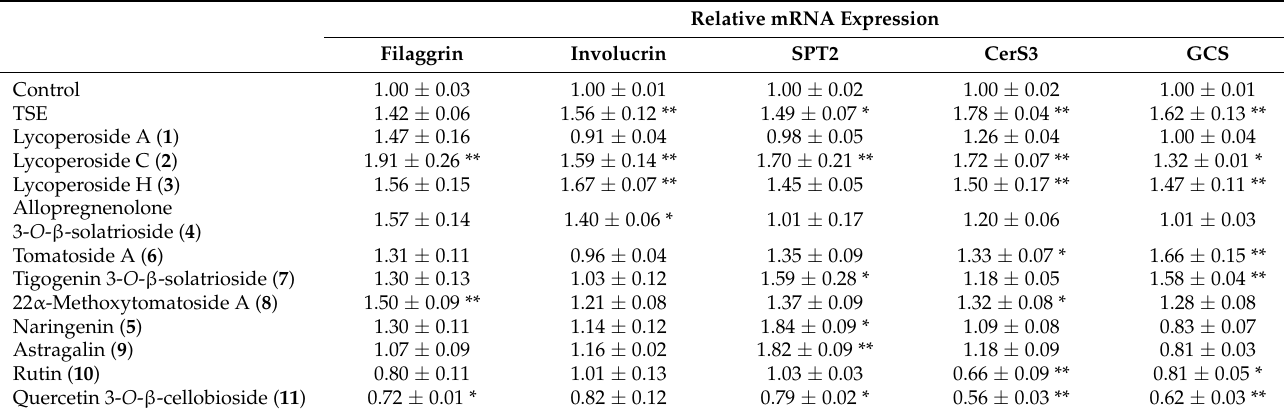
Table 1. Effects of TSE and isolated compounds ( 1 – 11 ) on the mRNA expression of proteins related to epidermal hydration in HaCaT